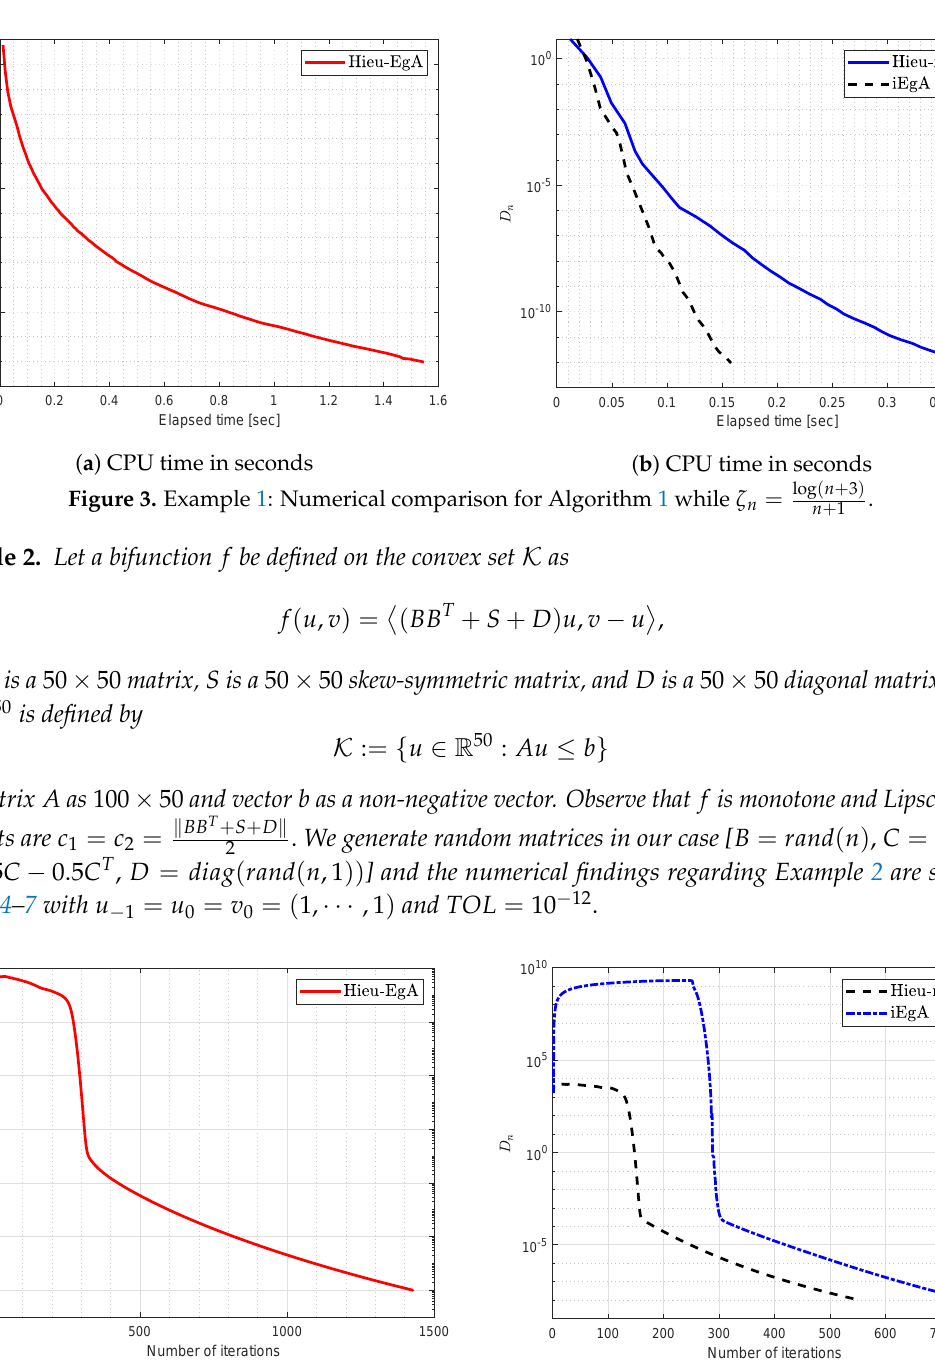
Figure 4. Example 2: Numerical comparison for Algorithm 1 while ζ n = 1